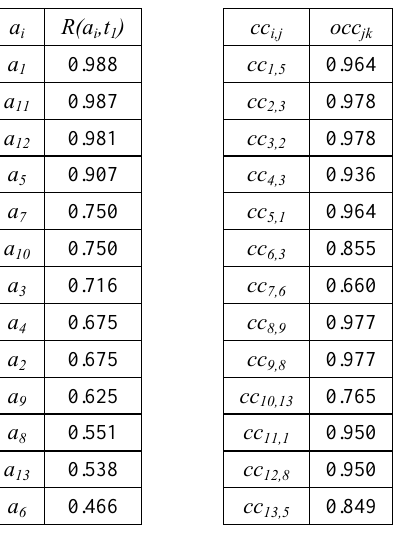
Table 7. Similarity between the descriptors and the fashion theme t 1 and the overall correlation coefficients between descriptors ( δ =0.5, γ =0.5 )